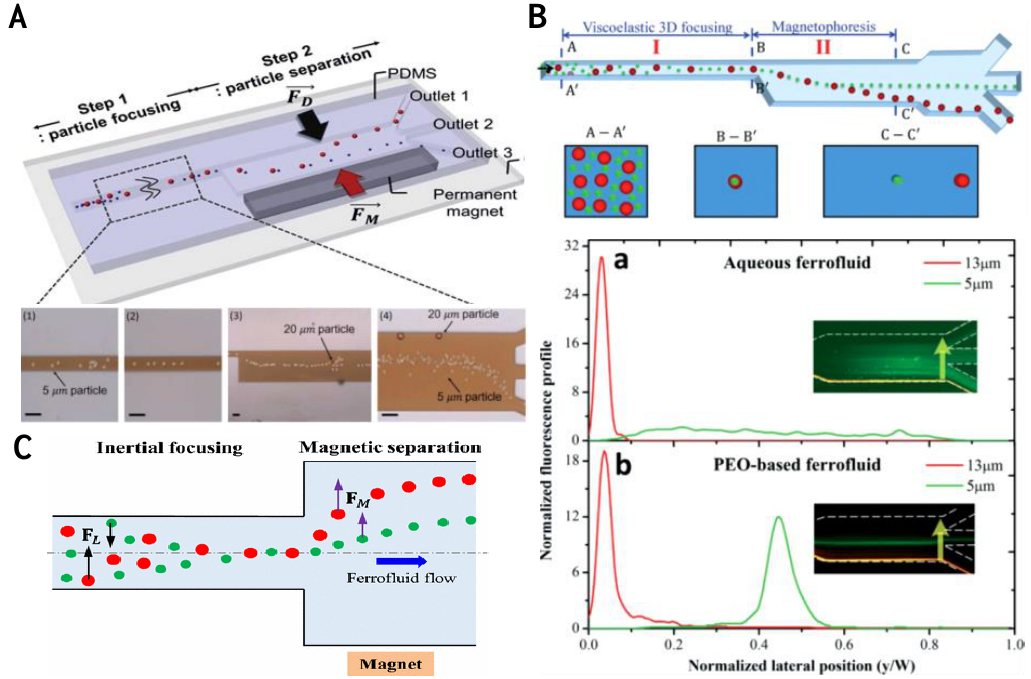
Figure 14. Negative magnetophoresis-based hybrid separation of particles in the flow of magnetic fluids. ( A ) Schematic of the setup (top) and the separation demonstration of elastically focused 5 µ m and 20 µ m PS beads in the flow of 0.4 wt% PEO and 10 wt% EMG 408 ferrofluid. Adapted with permission from Kim et al. [148], © 2016 The Royal Society of Chemistry. ( B ) Schematic illustration of viscoelastic focusing-enabled diamagnetic particle separation in a PEO-based ferrofluid (top); Comparison of the normalized fluorescence profiles for 5 µ m and 13 µ m PS beads at the channel outlet in the aqueous ferrofluid and PEO-based ferrofluid, respectively (bottom). Adapted with permission from Zhang et al. [149], © 2016 The Royal Society of Chemistry. ( C ) Schematic illustrating the inertially focused diamagnetic particle separation in a ferrofluid flow. Adapted with permission from Zhou et al. [150], © 2017 Springer.